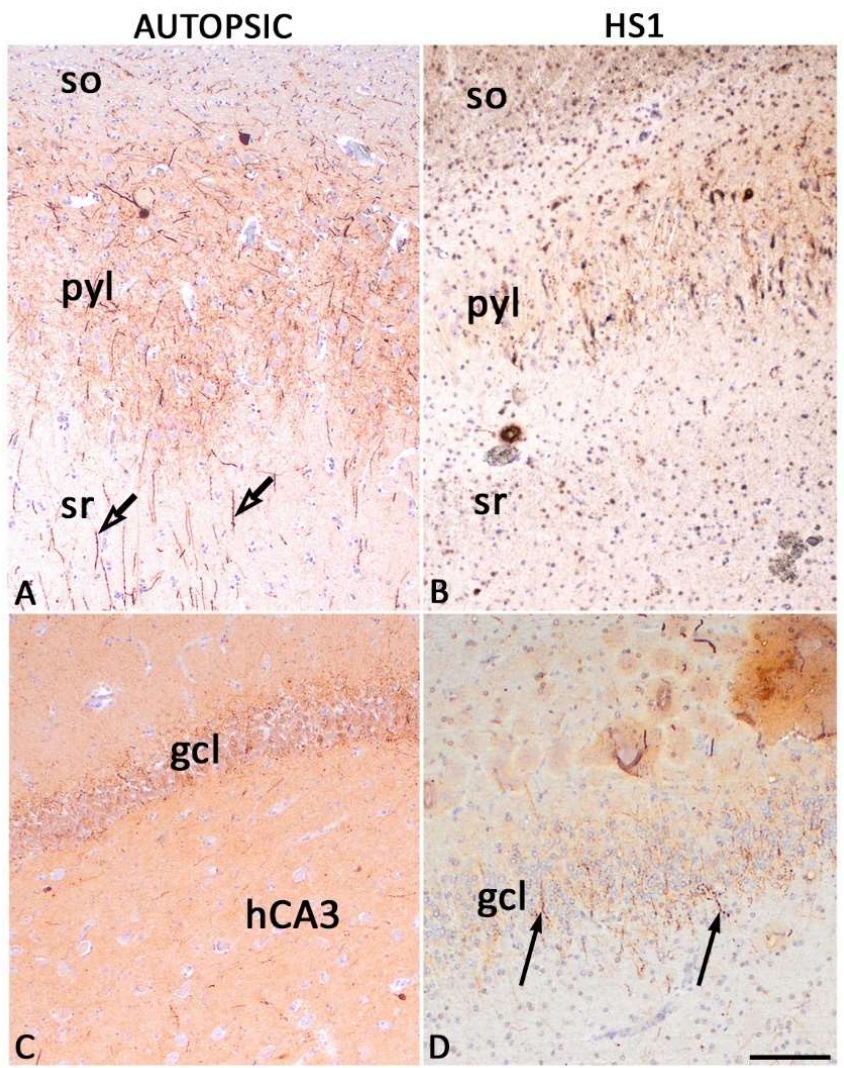
Figure 7. Comparison of parvalbumin expression in autopsic hippocampi ( A , C ) and HS1 ( B , D ). In comparison to autopsic hippocampi, parvalbumin-ir neurons in the pyramidal layer and stratum oriens in HS1 hippocampi are small, oval, and faintly stained ( A , B ). In autopsic hippocampi, the PARV-ir fibers are present around neurons in all CA fields, radially extending throughout the CA1 sr (arrows in ( A )). The loss of parvalbumin-ir neuropil in the autopsic hippocampus ( B ) is seen throughout the hippocampus, with this difference being most prominent in the stratum radiatum (sr) and pyramidal layer (pyl) of the CA1 field. In the granule cell layer (gcl) of the fascia dentata, parvalbumin-ir neuropil is present mostly as punctiform staining of fibers or continuously stained fibers ( C ). In HS1 gcl ( D ), there were fewer punctiform stained fibers than in autopsic hippocampi, but those that remained stained through their long axis, with parallel orientation, are easily observable (arrows in ( D )). so—stratum oriens; pyl—pyramidal layer; sr—stratum radiatum; hCA3—hilar CA3 field; gcl—granular cell layer. The magnification scale bar indicates 200 µ m and also refers to ( A – C ). The severe gliosis in the HS1 samples was obvious in sections IHC stained against the glial-acidic-fibrillary-protein (GFAP) (Supplemental Figure S5). The radially oriented GFAP immunoreactive fibers, seen clearly in the FD’s ml in autopsic hippocampi (Figure S3A),